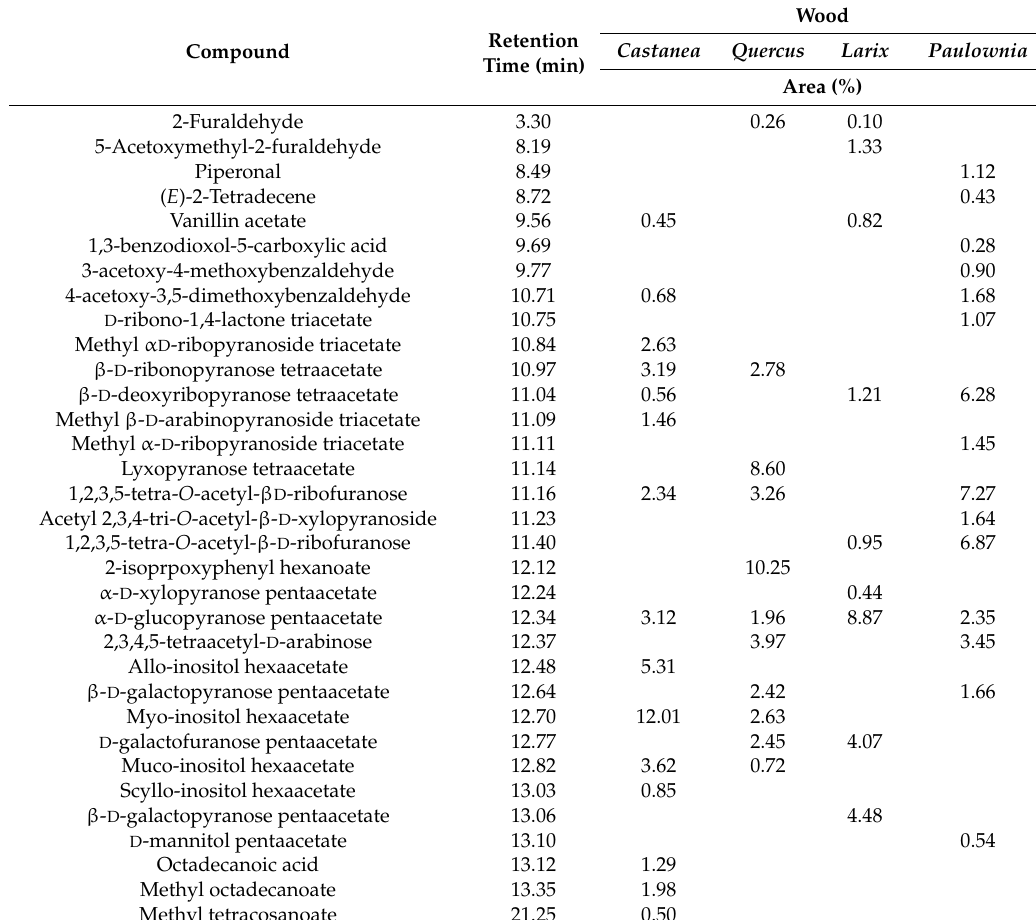
Table 6. GC-MS analysis of chloroform insoluble water extractives in the presence of H 3 PMo 12 O 40 after